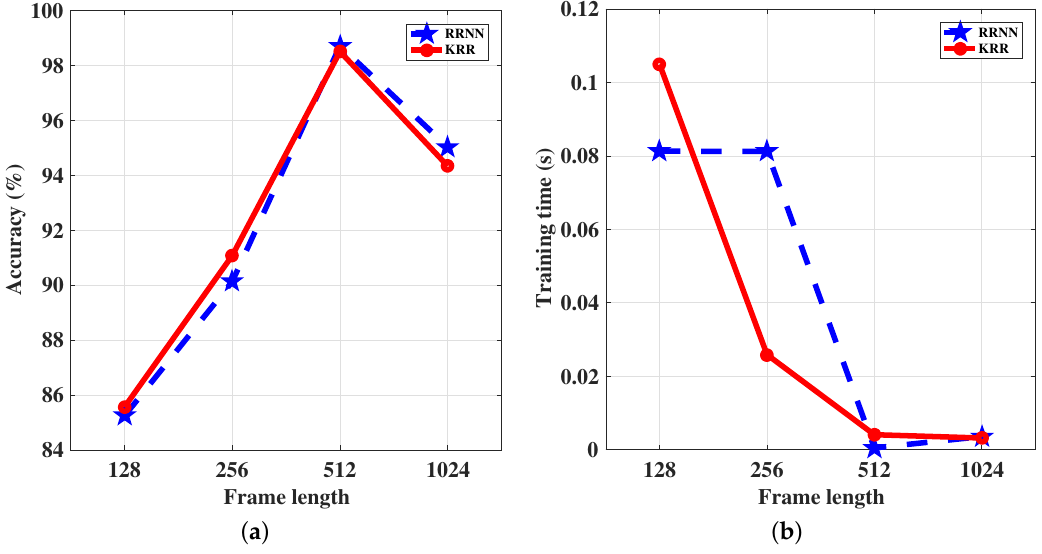
Figure 6. ( a ) Accuracy of the KRR and RRNN algorithms with varying frame lengths; ( b ) Training time for the KRR and RRNN algorithms with varying frame